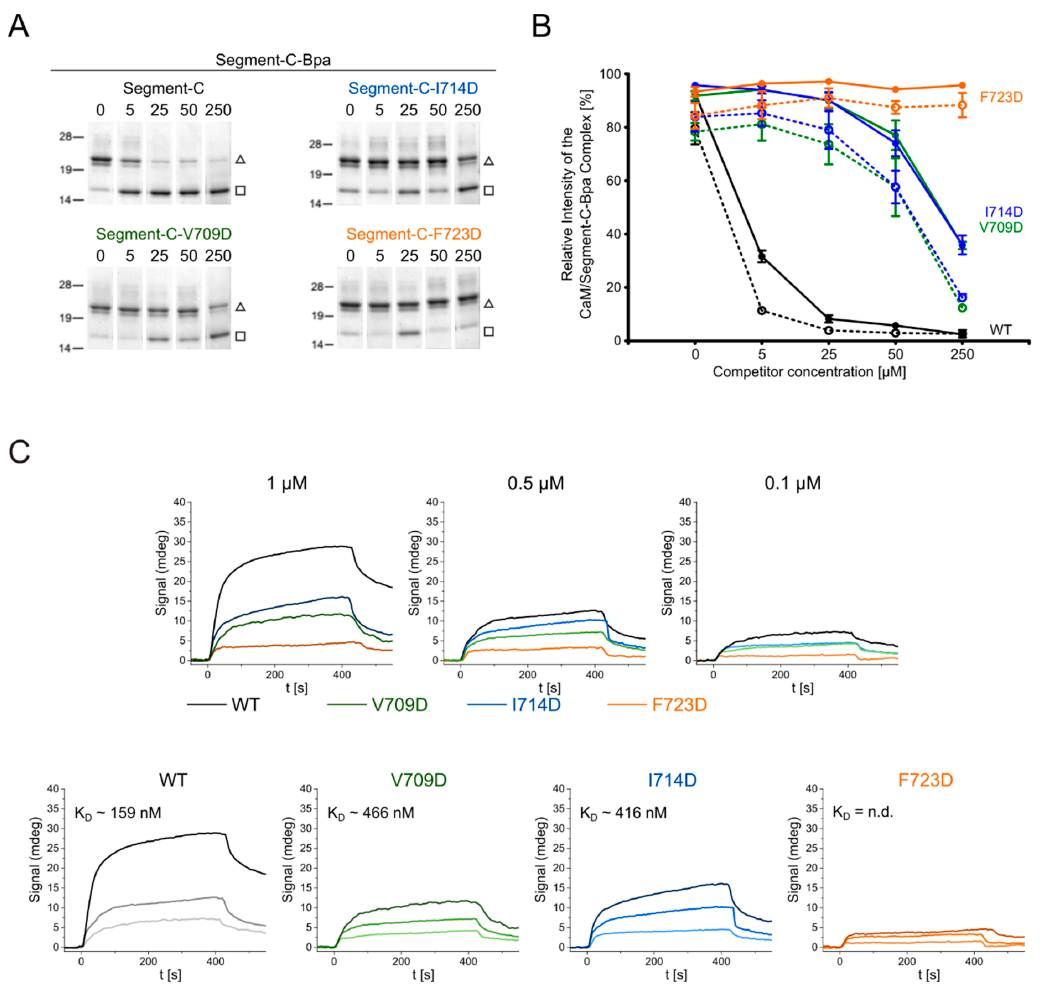
Figure 6. CaM/segment-C interaction studies by photoaffinity labeling and surface plasmon resonance. Amino acid sequences of segment-C variants are given in Table 3. ( A , B ) PAL-based competition assay of segment-C-Bpa with segment-C and its variants V709D (green), I714D (blue), and F723D (orange). ( A ) SDS-PAGE analysis of photoreactions; ( □ ) CaM, ( ∆ ) CaM/segment-C-Bpa 1:1 complex. ( B ) quantification of photoadduct yield (CaM/segment-C-Bpa signal); solid lines, quantification by SDS-PAGE analysis; dotted lines, quantification by MALDI-TOF-MS. The plot shows the mean of three independent experiments with standard error of mean (SEM) as error bars. A representative set of SDS gels and corresponding mass spectra is shown in Figure S11. ( C ) SPR measurements of wild-type (WT) and mutated segment-C variants V709D, I714D and F723D. Upper panel: sensograms of all variants for one concentration, lower panel: sensograms of one segment-C variant at di ff erent concentrations. K D values are given; n.d.: not